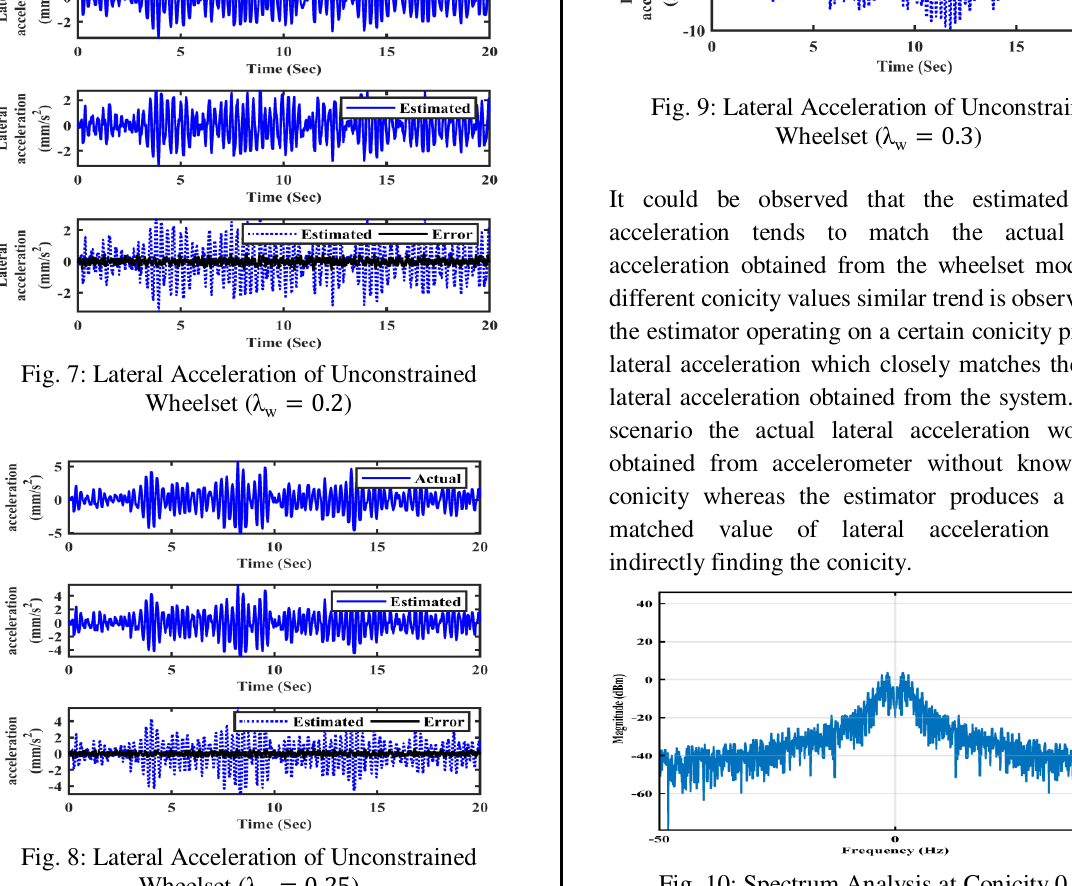
Fig. 10: Spectrum Analysis at Conicity